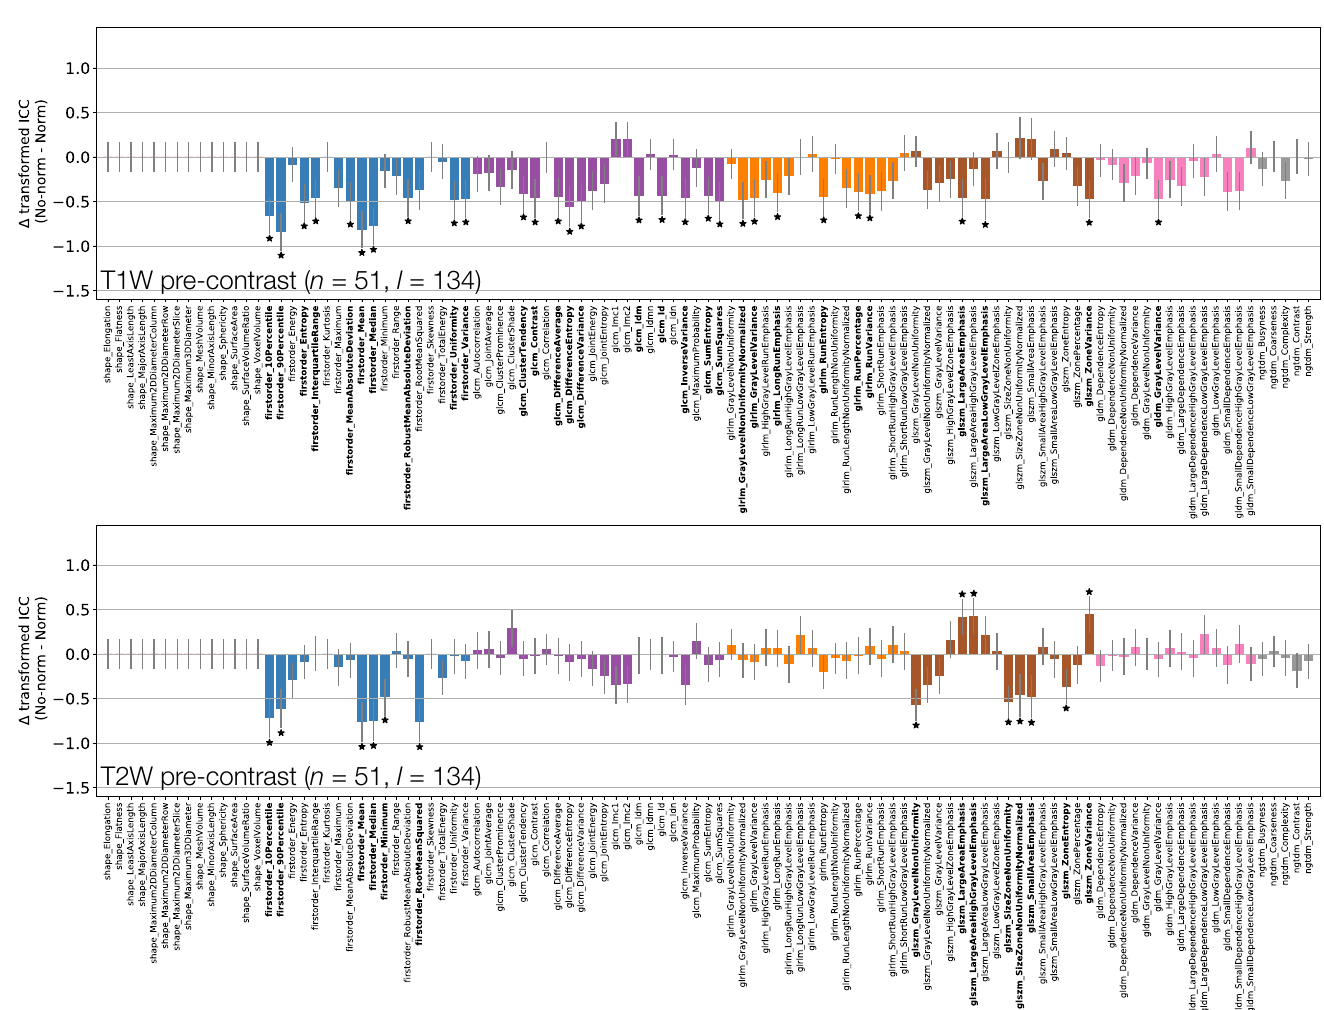
Figure 9. Effect of image normalisation on T 1 W and T 2 W pre-contrast images. Comparison of ICCs for Box–Cox transformed features from non-normalised and normalised images, for T 1 W (top) and T 2 W (bottom) pre-contrast images. Bars represent the difference in ICC point estimates (after applying Fisher’s Z -transformation), and error bars represent 95% CIs. Features are colour coded according to their class. Black stars and bold fonts indicate features where ICCs from non-normalised and normalised images are significantly